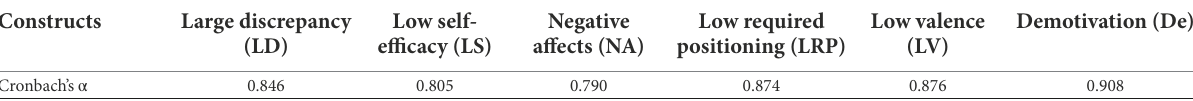
TABLE 5 Values of Cronbach’s α of